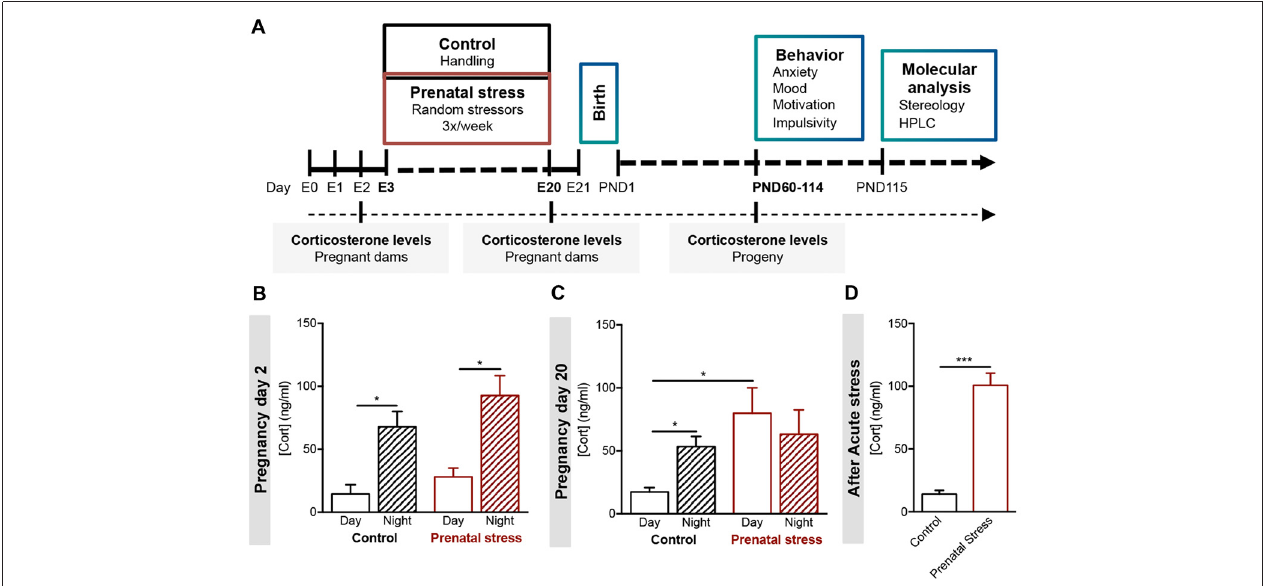
FIGURE 1 | Development of a model of prenatal exposure to unpredictable mild stress. (A) Experimental timeline. Pregnant females Wistar han rats (age of 8 weeks, n = 6) were exposed to an unpredictable stress protocol (consisting of strobe lights, restraint or noise), applied three times per week in a random fashion from day 3 to day 20 of pregnancy (progeny—prenatal stress group). Progeny of control group derived from age-matched female rats that were handled daily throughout pregnancy. Blood samples were collected from all pregnant dams on day 2 and day 20, and from progeny in adulthood. Different behavioral tests were conducted in young adult male and female progeny. Stereological measurements and catecholamine levels of specific brain regions were evaluated in the progeny. (B) Morning (8 am) and night (8 pm) serum corticosterone levels of control and stress-exposed prenatal stress (PS) pregnant dams were measured at the beginning of pregnancy (day 2, n = 5) and (C) at the end of pregnancy (day 20, n = 4). PS pregnant dams present a disruption in corticosterone circadian secretion at later stages of gestation. (D) Corticosterone levels of control and PS mothers were also measured after exposure to an acute stressor (restraint for 30 min; n = 4). PS mothers present significantly higher corticosterone secretion after acute stress in comparison to controls group. Error bars denote SEM. ∗ p < 0.05, ∗∗∗ p < 0.001.